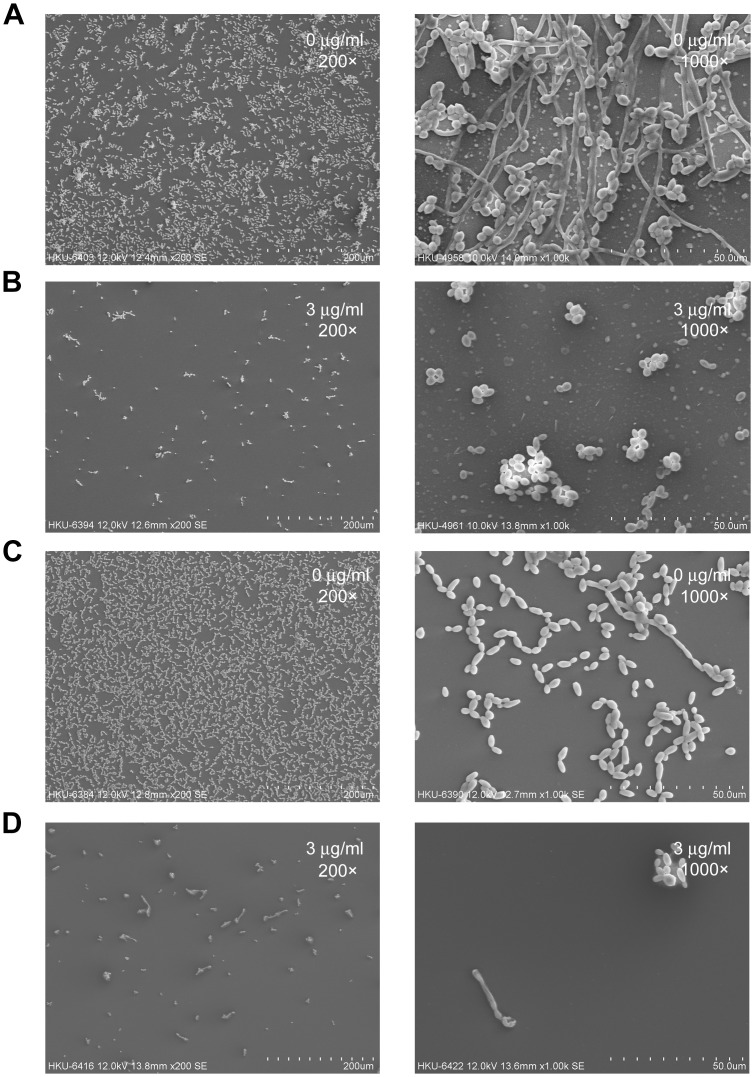
Scanning electron microscopy images of Candida albicans biofilms.Purpurin exhibited profound inhibitory effect on C. albicans biofilm formation and pre-formed biofilms. Fungal biofilms were formed on plastic coverslips, processed and coated with gold before viewing with a scanning electron microscope at low (200×) and high (1000×) magnifications. A) Biofilm formation without purpurin. B) Biofilm formation with 3 µg/ml of purpurin. C) Pre-formed biofilms without purpurin. D) Pre-formed biofilms with 3 µg/ml of purpurin.